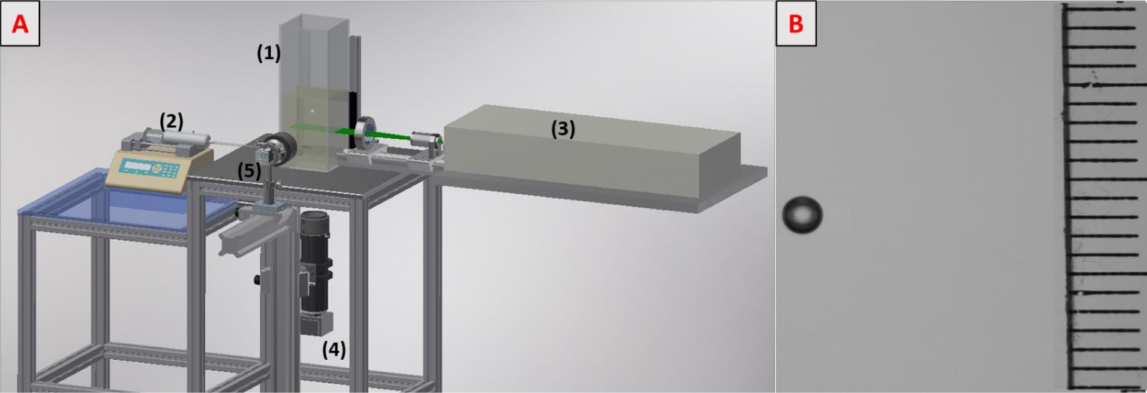
Figure 1. ( A ) Experimental set-up. ( B ) Visualization of a bubble rising in water containing 0.02 g/L of Triton X-100 in